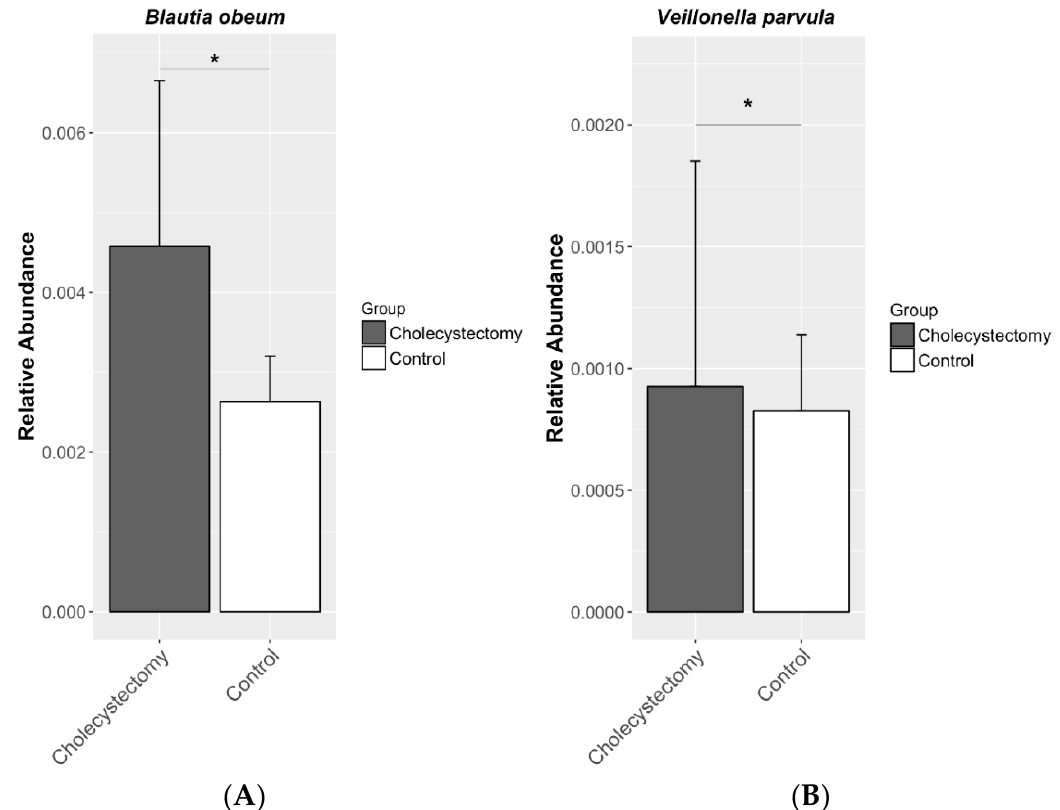
Figure 3. Relative abundances of ( A ) Blautia obeum and ( B ) Veillonella parvula in the gut microbiota. Both species were more abundant in the cholecystectomy group. * q < 0.05 (generalized linear models, Benjamini–Hochberg correction).